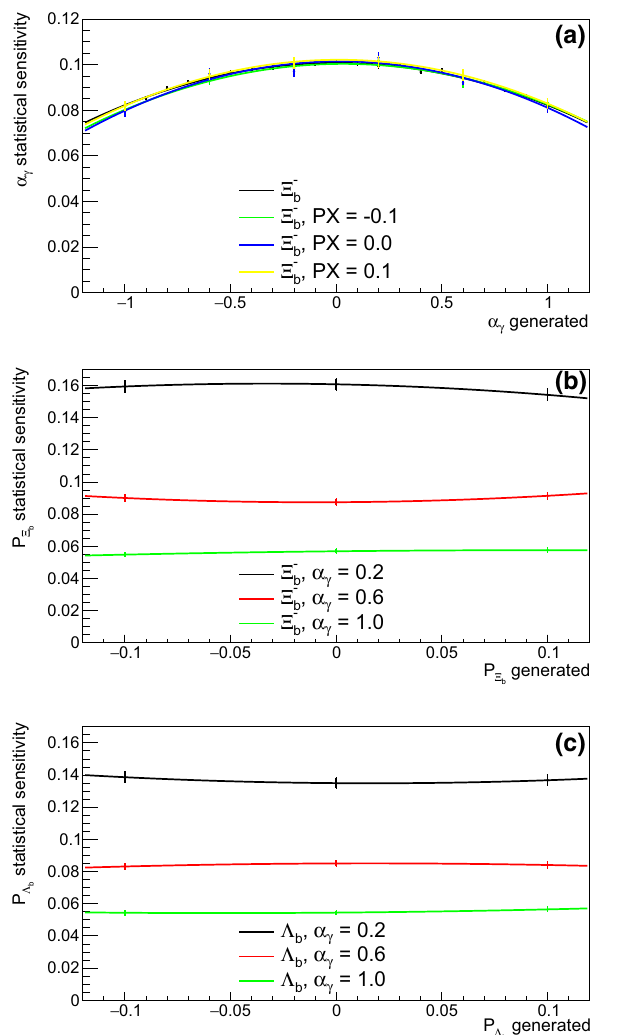
Fig. 5 a Sensitivity to the photon polarization as function of its value for different assumptions of the initial Ξ − polarization. The black line b corresponds to the fit of Eq. (10), which does not include the polar angle ofthe Ξ − momentumrelativethenormalvectortotheproductionplane, whiletheotherlinecorrespondtothethefitofEq.(9).Similarresultsare obtained for the Λ 0 polarization. b Sensitivity to the Ξ − polarization b b for different values of α γ using Eq. (9). as function of its value for Ξ − b c Sensitivity to the Λ 0 polarization as function of its value for Λ 0 for b b different values of α γ using Eq. (9). In these figures dots with errors correspondtothefitresults.Asecondorderpolynomialissuperimposed for better visualization